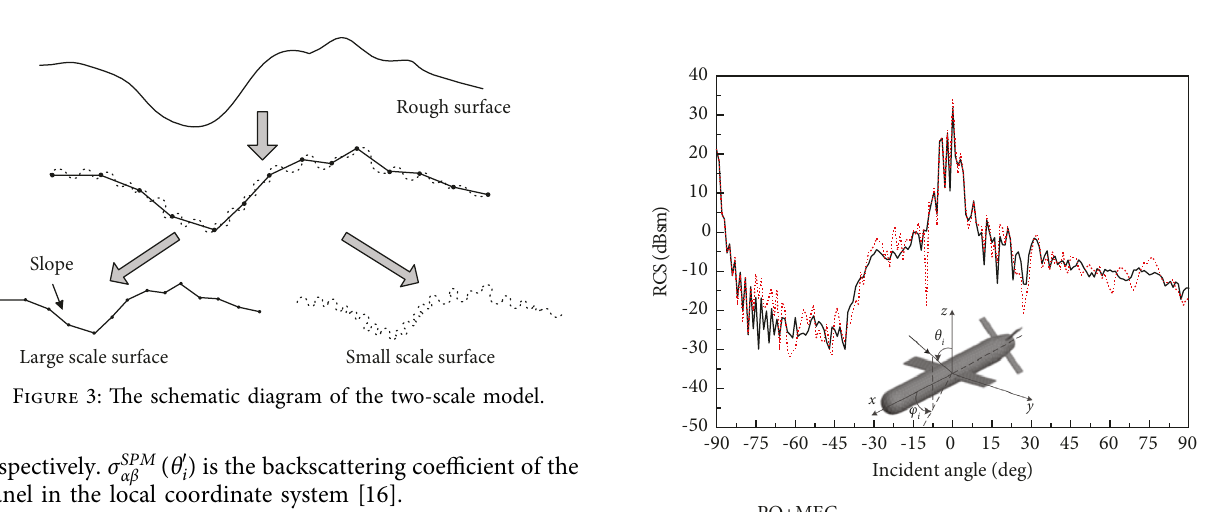
Figure 4: The schematic diagram of two-scale